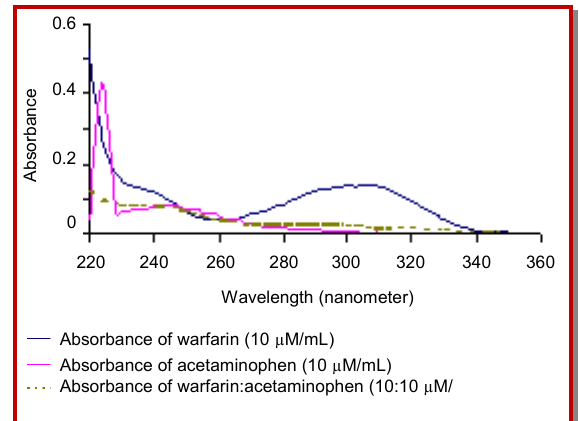
Figure 1: Corresponding zero order absorption spectrum of warfarin (10 µM/mL); acetaminophen (10 µM/mL) and war-